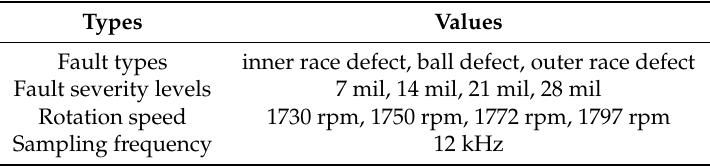
Figure 2. Experimental setup of the rolling bearings for Case Western Reserve University (CWRU) [32]. Table 1. Experimental settings of machine rotation experiments.